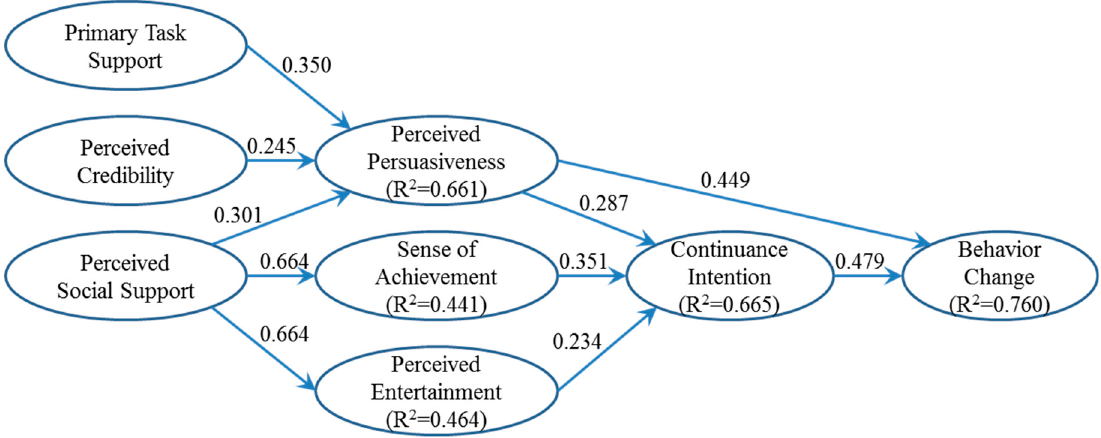
Figure 4. Standardized model estimates. Note: All regression weights were significant at the 0.001 level (two-tailed test).